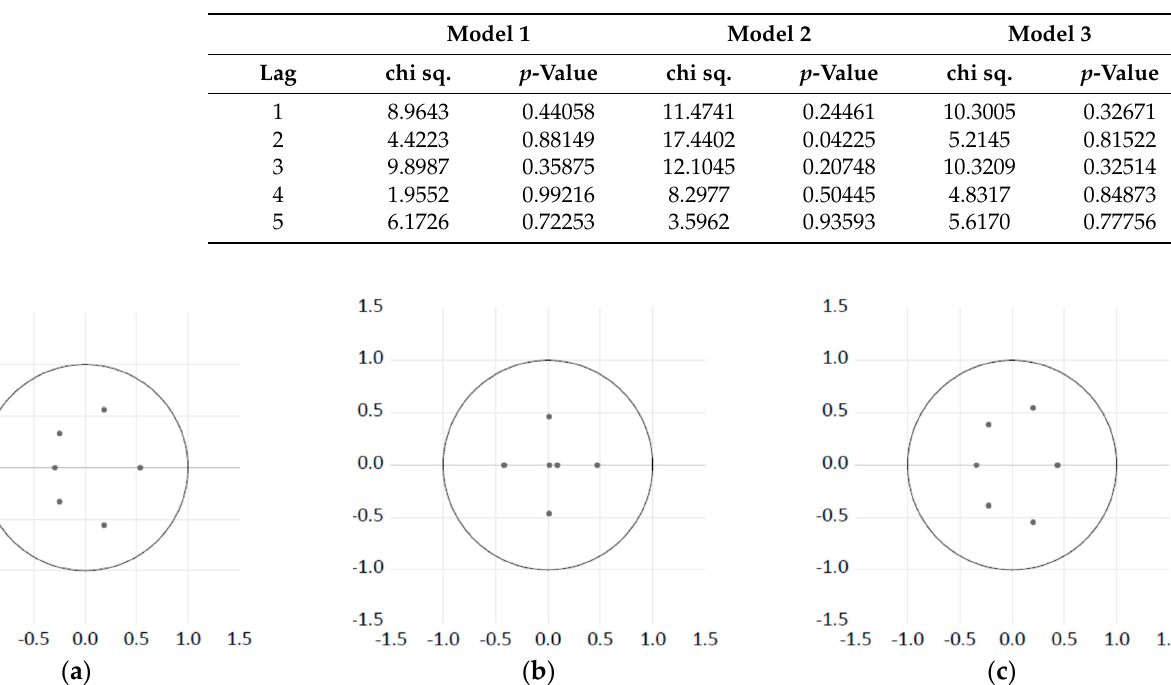
Table 8. Residual serial correlation LM test.